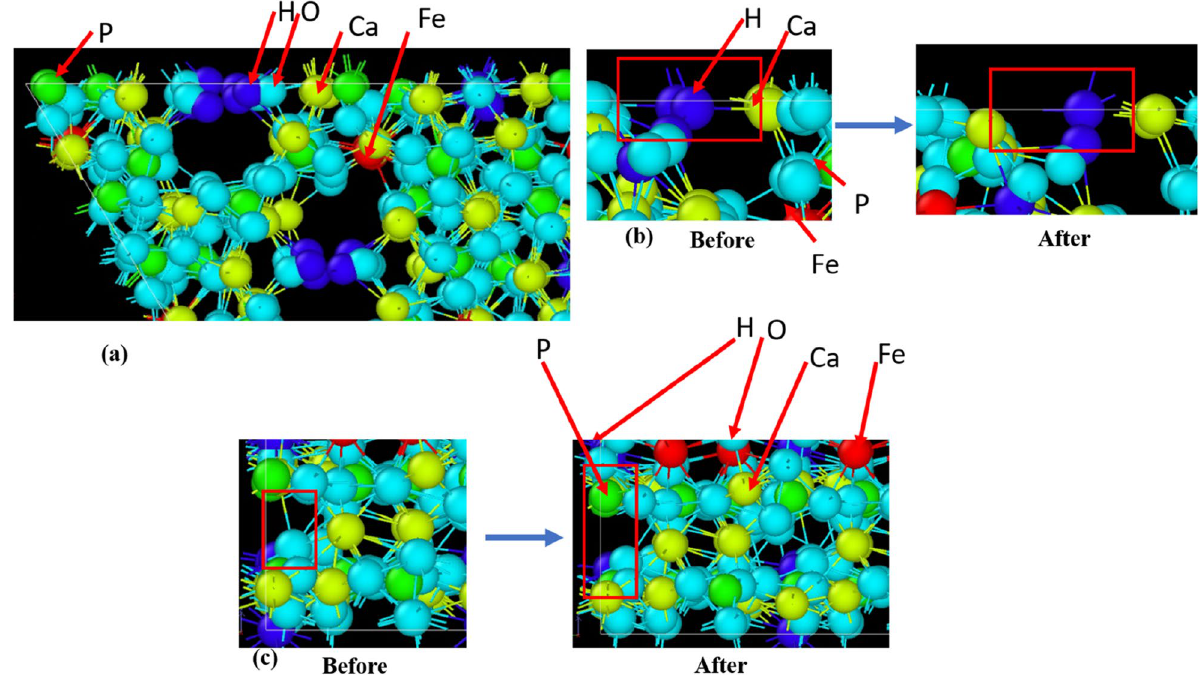
Figure 10. MD simulation acquired snapshot of 10FeHA at T = 300 K at the vicinity of TS (highest point on the stress-strain curve) when loaded along ( a ) X, ( b ) Y, and ( c ) Z axis. “Before” and “After” indicates the state of the system prior and after bond breaking at TS point. The region(s) marked by red square highlights broken bond(s). (Sample designation: xFeHA means x mol% Fe 2+ -doped HA).